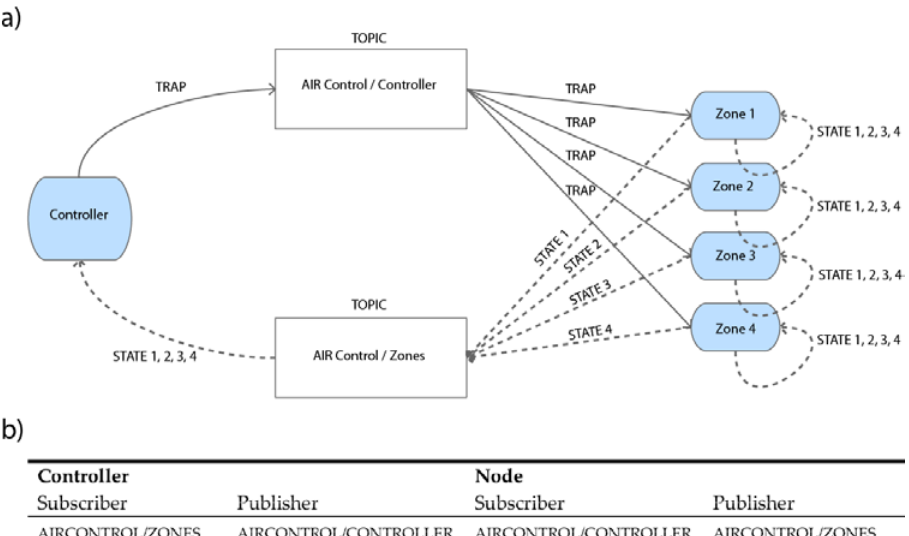
Figure 6. ( a ) Scheme of the topics assignment and ( b ) configuration.